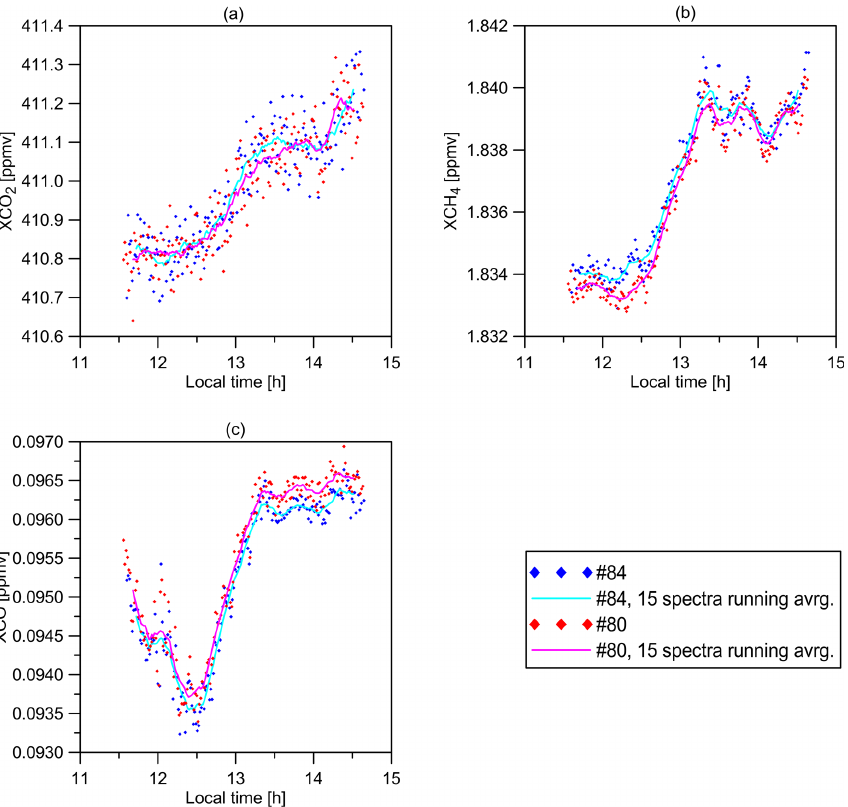
Figure 5. The scaled results of the side-by-side measurements of XCO 2 , XCH 4 and XCO by FTS no. 80 and FTS no. 84 on 12 April